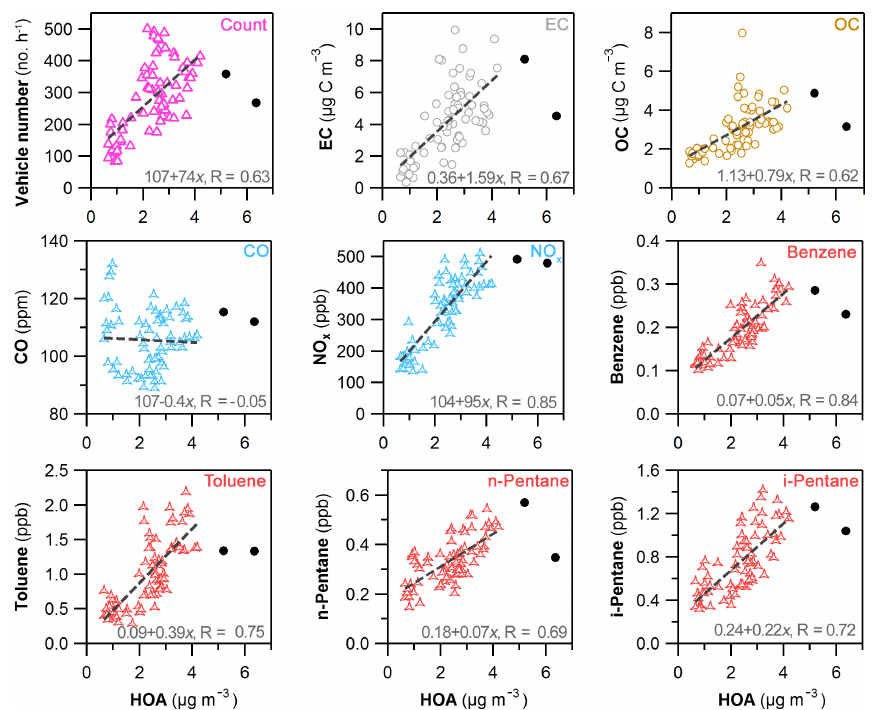
Figure 2. Scatter plot of vehicle count, mass concentration of EC, OC and gas-phase concentrations of various VOCs, NO x , and CO against HOA during the period 28–31 May 2013; linear least squares fits with equations and Pearson’s R values in gray; black dots signify outlier values excluded from the line